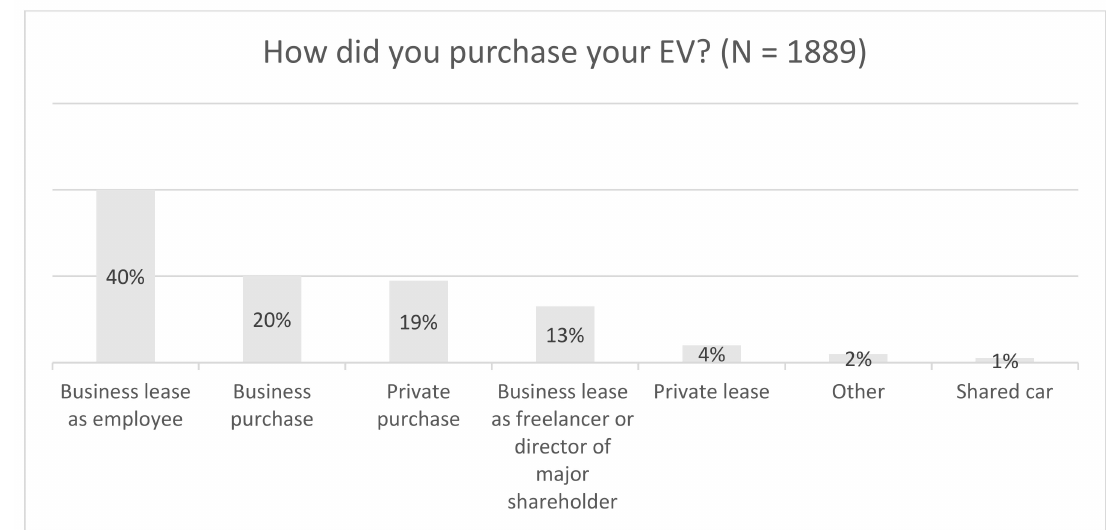
Figure 1. Vehicle